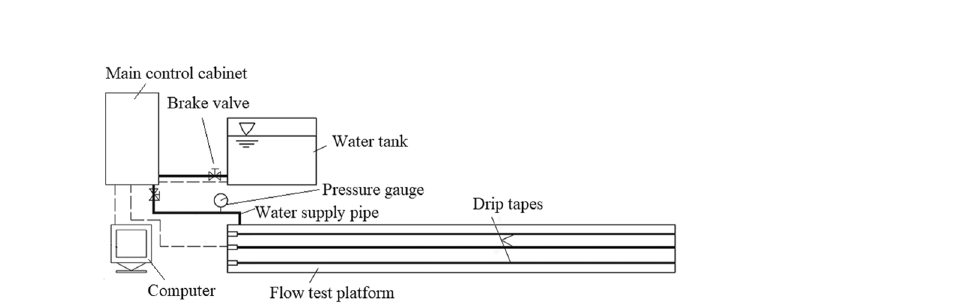
Figure 3. Schematic of anti-clogging performance test platform for drip irrigation